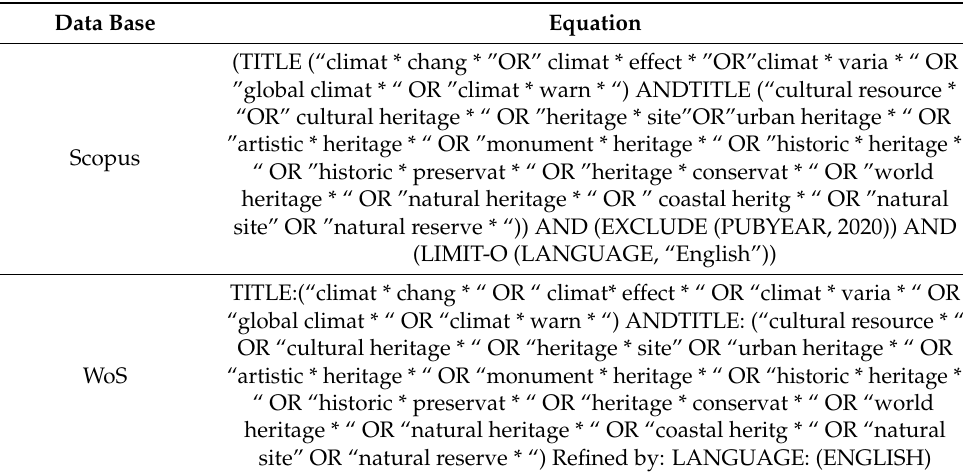
Table 1. Search equations by